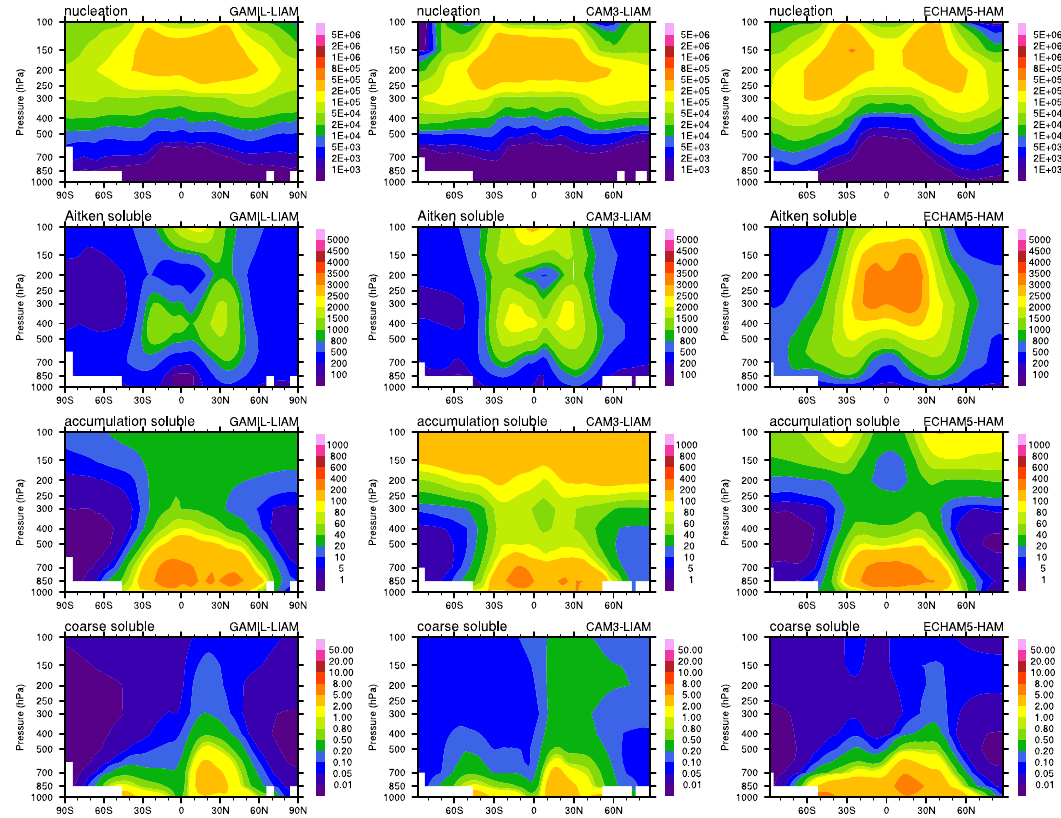
Fig. 1. Zonal and annual mean aerosol number concentrations of the four soluble modes (from top to bottom) simulated by GAMIL-LIAM (left column), CAM3-LIAM (middle column) and ECHAM5-HAM (right column). The unit is number of particles per cubic centimeter at the standard atmospheric state (1013.25hPa, 273.15K).